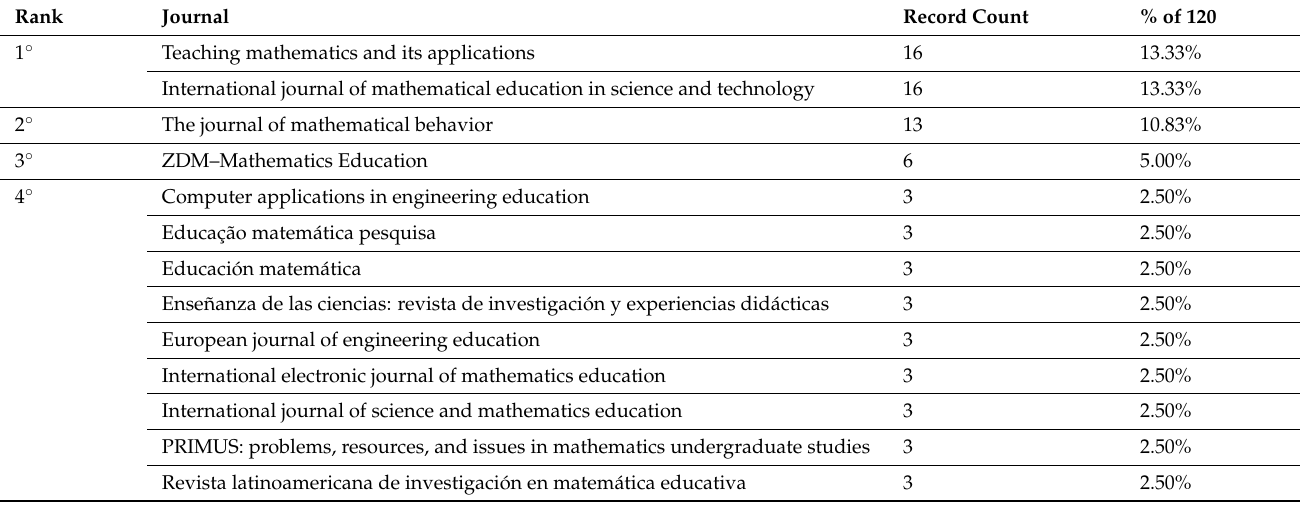
Table 2. The top four journals according to the number of published articles.